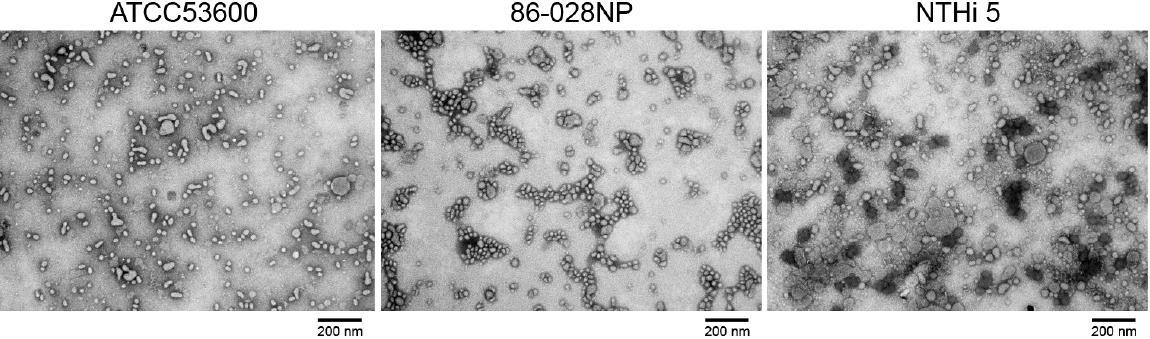
Figure 2. Transmission electron micrographs (TEM) images of OMVs isolated from three different NTHi strains as indicated. Images are taken at 67,000× magnification.